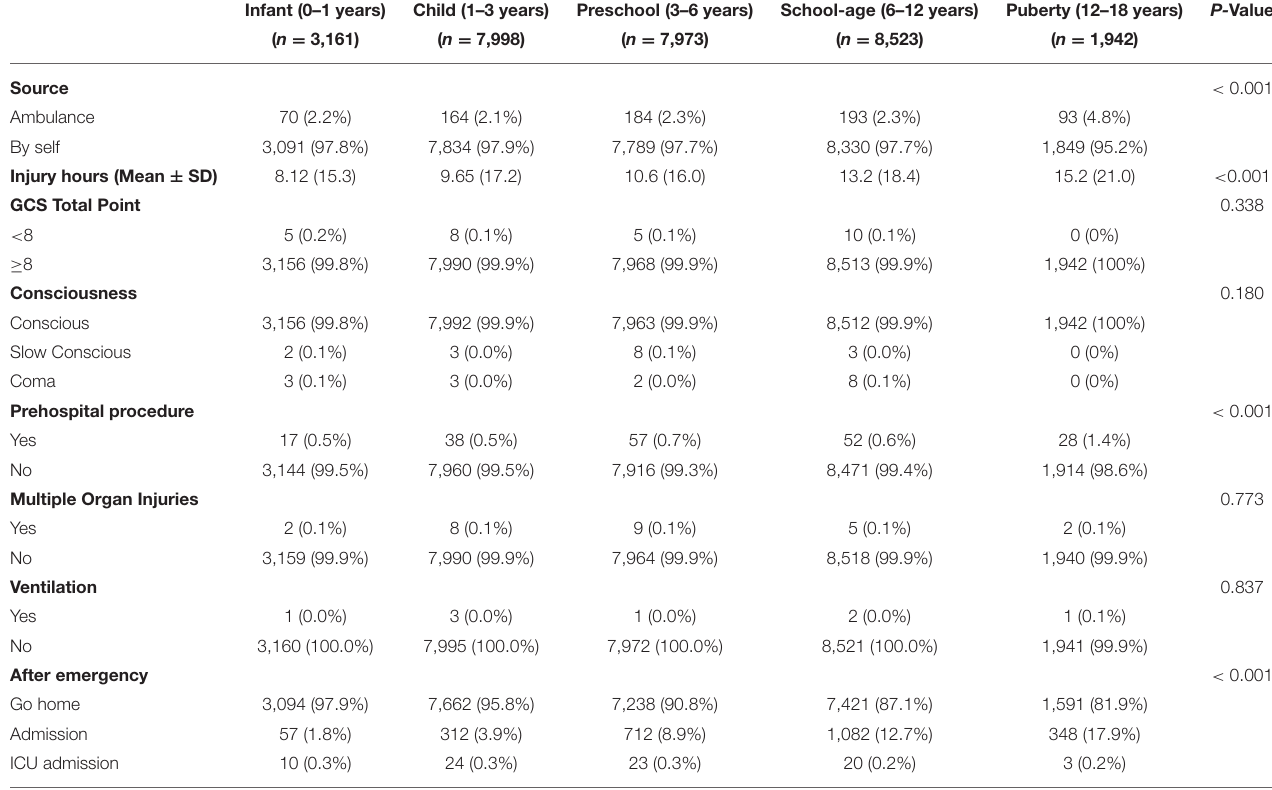
TABLE 2 | Characteristics of child unintentional injury patient in the emergency department by age-group.